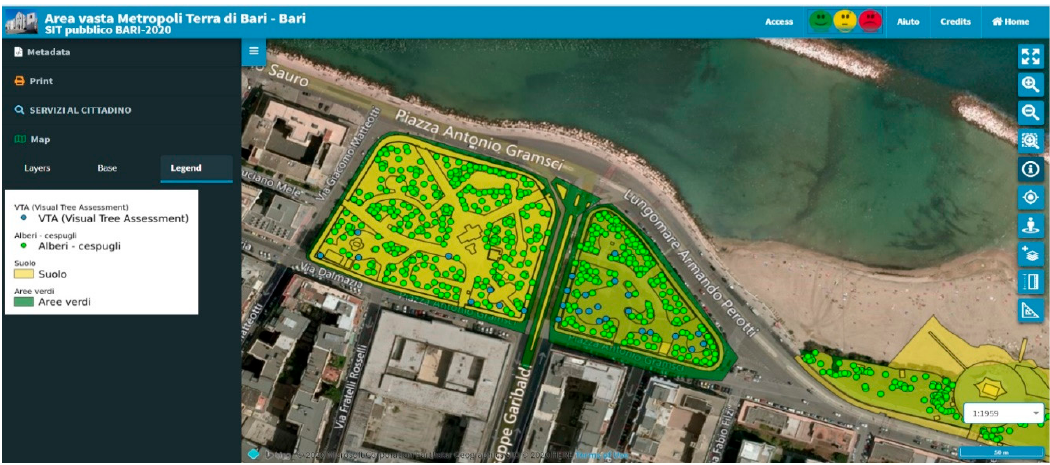
Figure 4. The Territorial Information System (SIT) of the Area Vasta Metropoli Terra di Bari. Source: own study based on data from https://sit.egov.ba.it/en/map/bari/qdjango/106/.